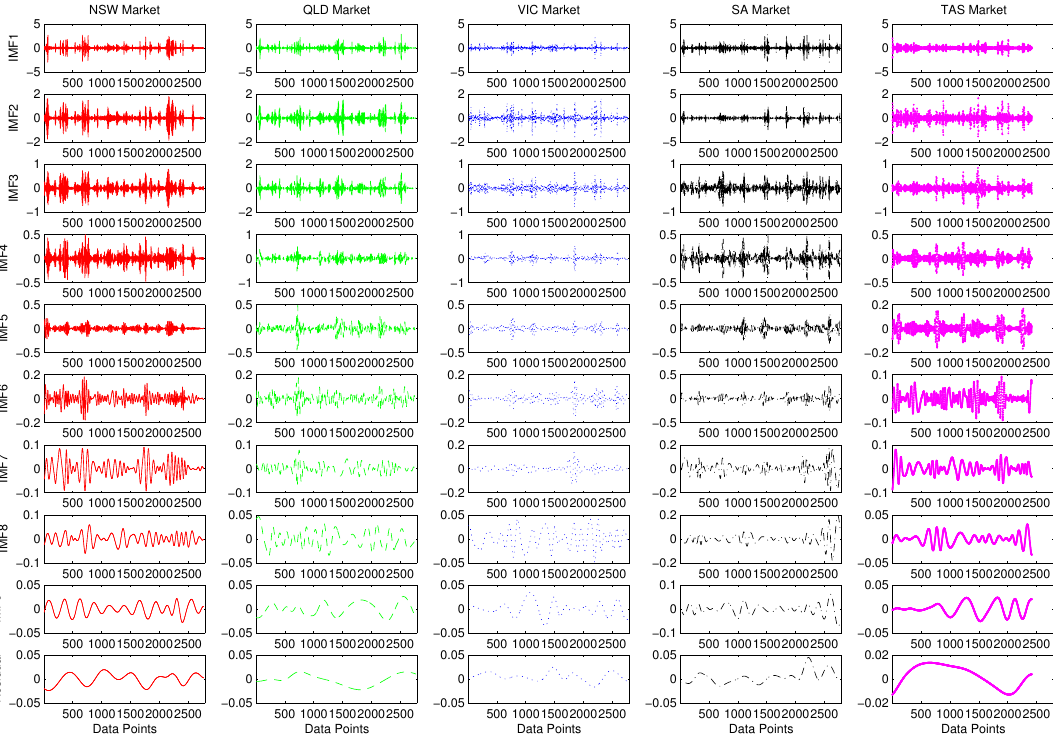
Figure 1. Decomposed Intrinsic Mode Functions (IMFs) using the Empirical Mode Decomposition (EMD) algorithm in Australian electricity markets. NSW: New South Wales; QLD: Queensland; SA: South Australia; VIC: Victoria; TAS: